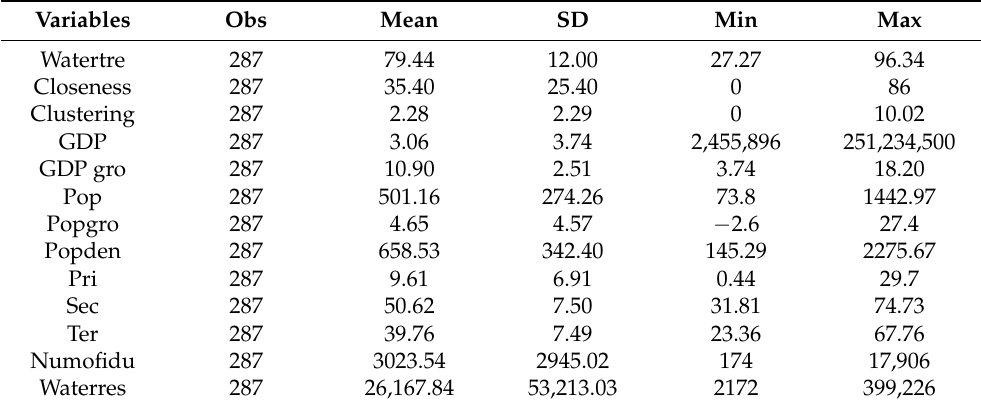
Table 2. Descriptive